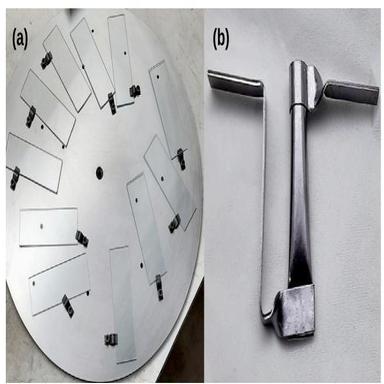
Diffusion pump based coating unit for deposition of tin.